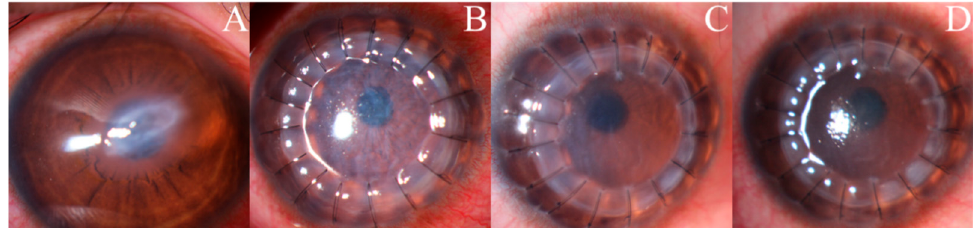
Figure 3. Anterior segment photographs of a patient with a normal pupil during the 4.5-month follow-up period. A 32-year-old male with keratoconus (with acute hydrops) in his right eye: ( A ) preoperatively; ( B ) one day postoperatively; ( C ) two months and two weeks postoperatively; ( D ) four months and two weeks postoperatively.